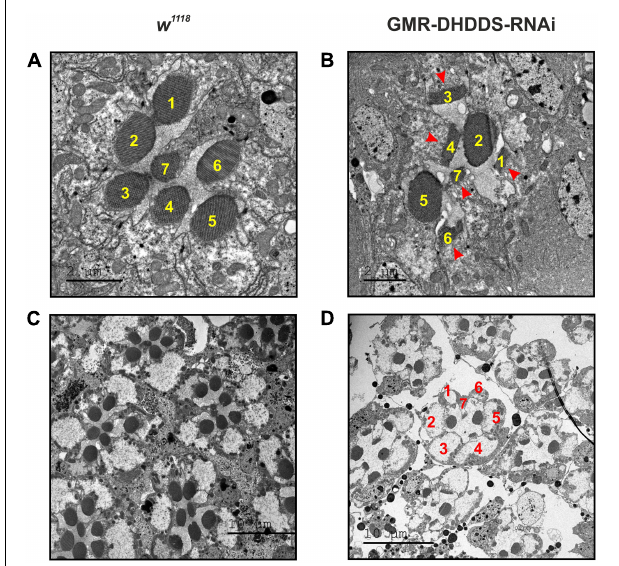
FIGURE 3 | Retinal TEM sections of GMR-DHDDS-RNAi knockdown flies revealed a unique pattern of photoreceptors degeneration. Thin TEM sections at a ∼ 40 µ m depth (from the corneal surface) of dark-raised newly eclosed w 1118 (A,C) and experimental GMR-DHDDS-RNAi (B,D) retina at high magnification ( × 2000, A and × 1500, B ) and low magnification ( × 500, C,D ). The identity of the various photoreceptors was determined by the position of the easily identified R7. (A) A representative TEM section of a single ommatidium of a newly eclosed dark-raised w 1118 fly in which the different photoreceptors are identified by their numbers. (B) A representative TEM section of a single ommatidium of a newly eclosed dark-raised GMR-DHDDS-RNAi fly in which the different photoreceptors are identified by their numbers. Note the normal appearance of the rhabdomeres of R2 and R5 cells and the degenerated appearance of the other cells showing very short microvilli (arrows). (C) Seven neighboring ommatidia are presented at a lower magnification ( × 500). Similar TEM with a normal retinal structure was previously described for the white-eyed GMR/+ control strain of older age (Weiss et al., 2012). (D) Several neighboring ommatidia of the GMR-DHDDS-RNAi fly are presented at lower magnification ( ×